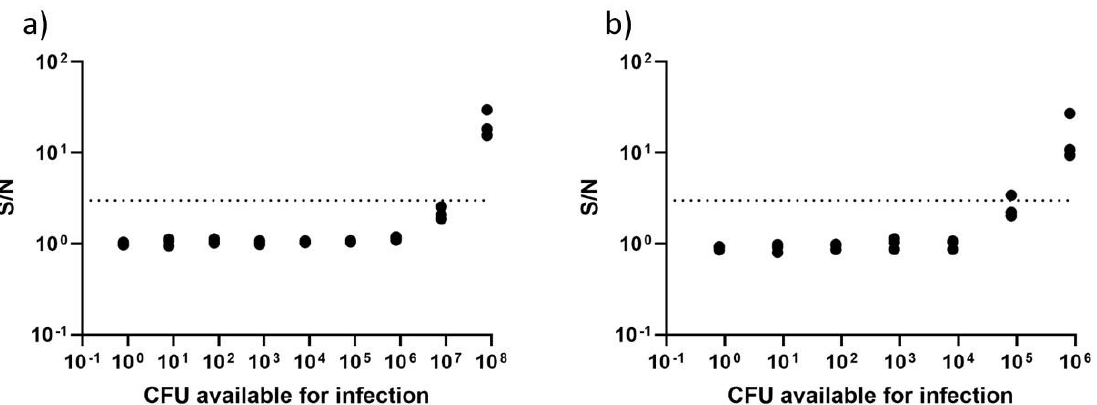
Figure 4. Signal to noise ratio versus colony forming units (CFU) available for infection in 880 mL. ( a ) T7 ALP* /DynaLight and ( b ) T7 NLuc /Nano-Glo. S/N of 3:1 is indicated by a dashed line. (n = 3).